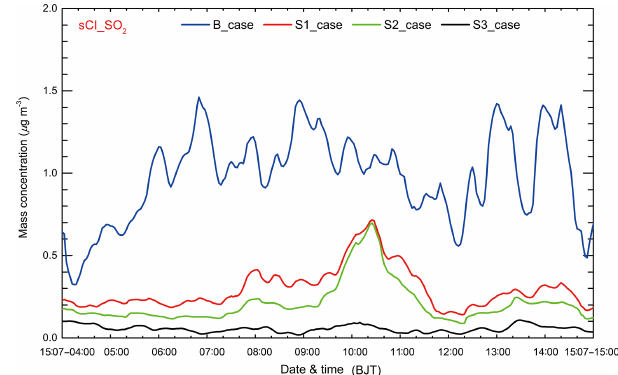
Figure 11. Temporal variations of the simulated average sulfate concentration contributed by sCI_SO 2 (blue line: B case; red line: S1 case; green line: S2 case; black line: S3 case) in BTH from 4 to 15 July